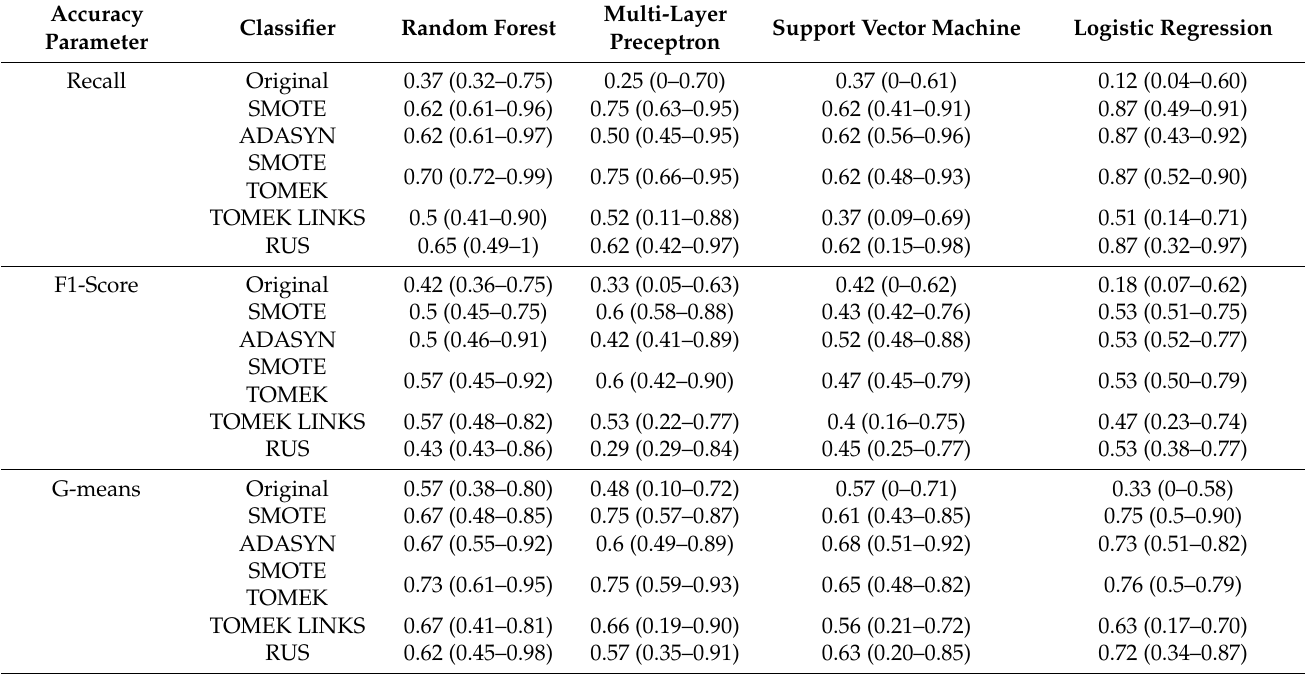
Table 4. Accuracy and 95% confidence interval of wildfire size prediction based on (a) Recall, (b) F1-score, and (c)